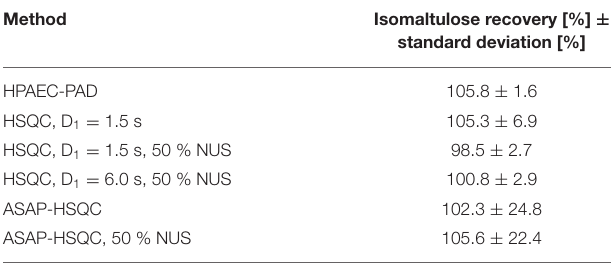
TABLE 2 | Recoveries of isomaltulose determined by spiking food product